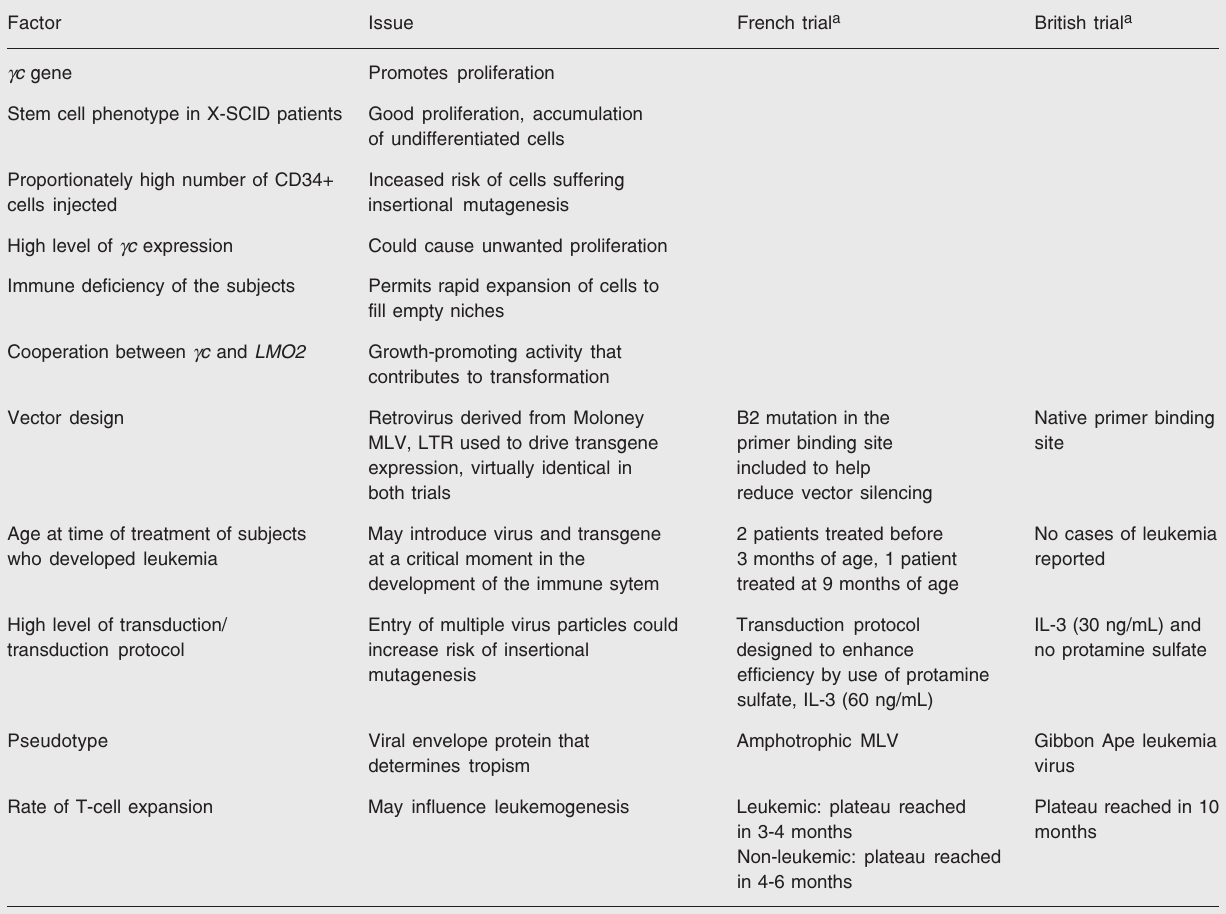
Table 2. Potential factors contributing to the development of leukemia in the French X-linked severe combined immunodeficiency (X-SCID) trial and differences, when present, compared to the British